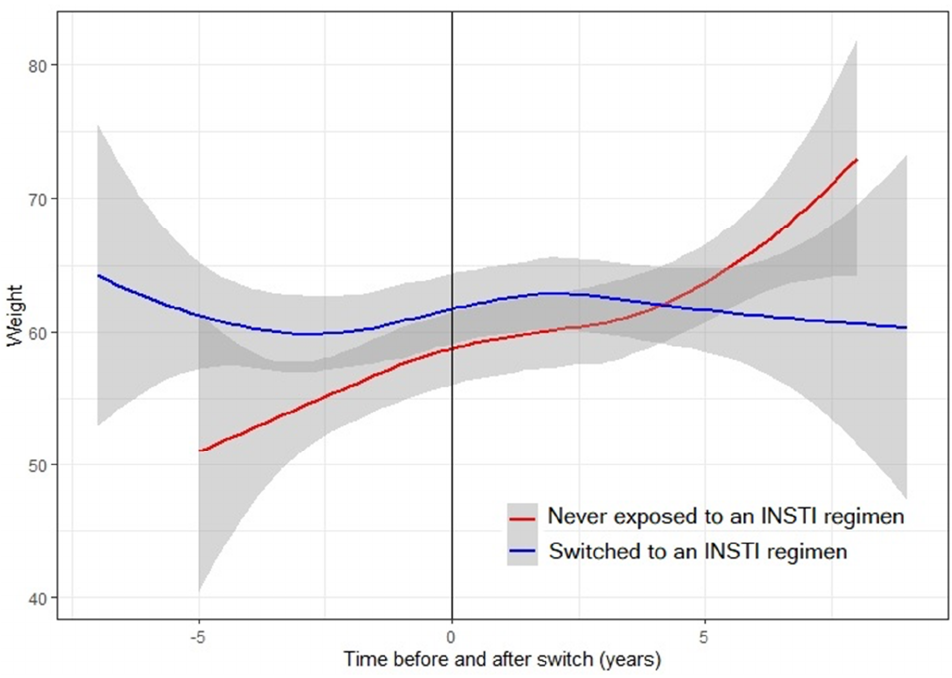
Figure 1. Weight trend during the 10 years follow up in people perinatally infected with HIV, treated with or without integrase strand transfer inhibitors (INSTI)-based antiretroviral regimens.